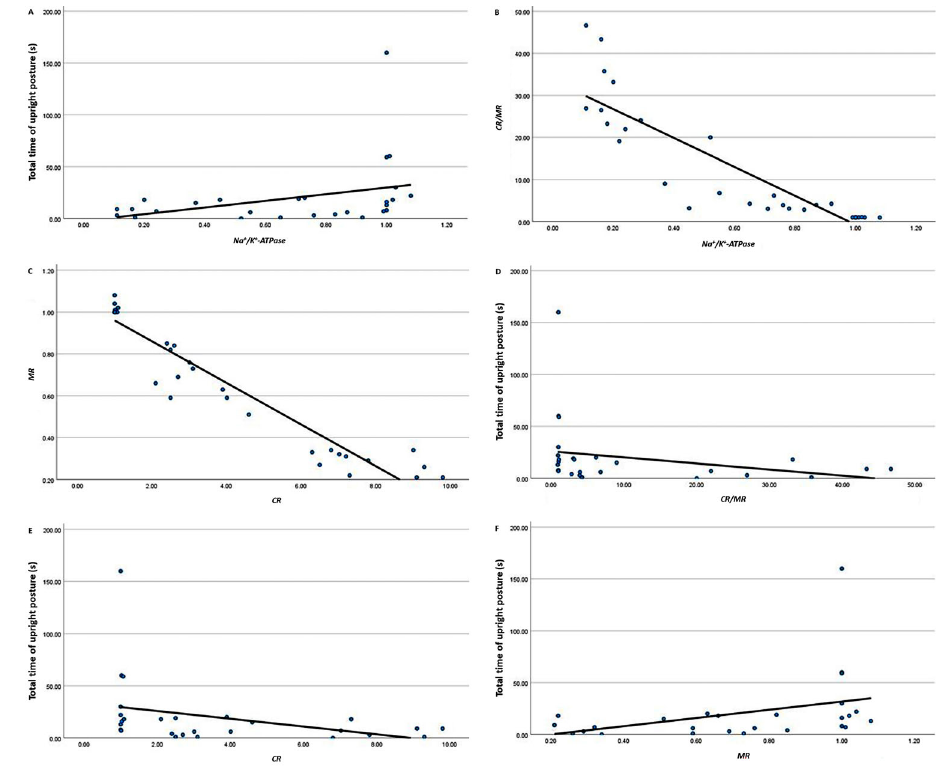
Figure 5. Correlations between A ) sodium/potassium pump relative gene expression and duration of upright posture (r=0.487, P = 0.010); B ) Relative gene expression of Na + /K + -ATPase and of hippocampal corticosterone receptors to melatonin receptors ( CR/ MR ) relative expression (r= – 0.931, P=0.001); C ) Relative CR expression and relative MR expression (r= – 0.938, P=0.001); D ) duration of upright posture and hippocampal CR/MR relative expression ratio (r= – 0.477, P=0.012); E ) duration of upright posture and hippocampal CR relative expression (r= – 0.508 and P=0.007); F ) duration of upright posture and relative expression of MR (r=0.451, P=0.018) (n=30). Spearman